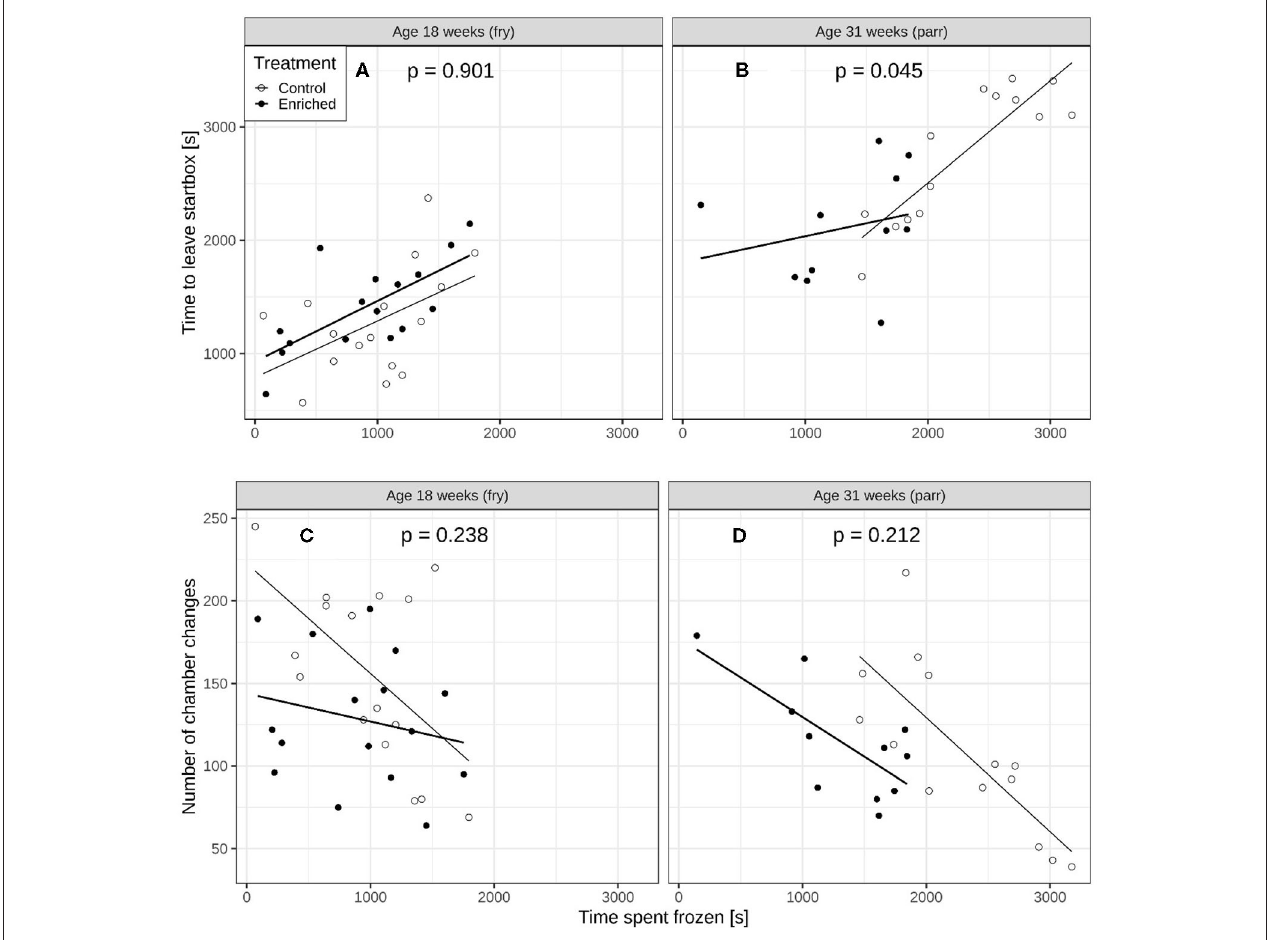
FIGURE 3 | Comparisons of enriched reared and control reared juvenile Atlantic salmon ( Salmo salar ). Time to leave start box vs. time spent immobile for (A) 18-week-old and (B) 31-week-old juveniles. The p -values on each panel refer to the interaction term and represent a comparison of slope between the two regression lines. Number of chamber changes versus time spent immobile for (C) 18-week old and (D) 31-week old juveniles.